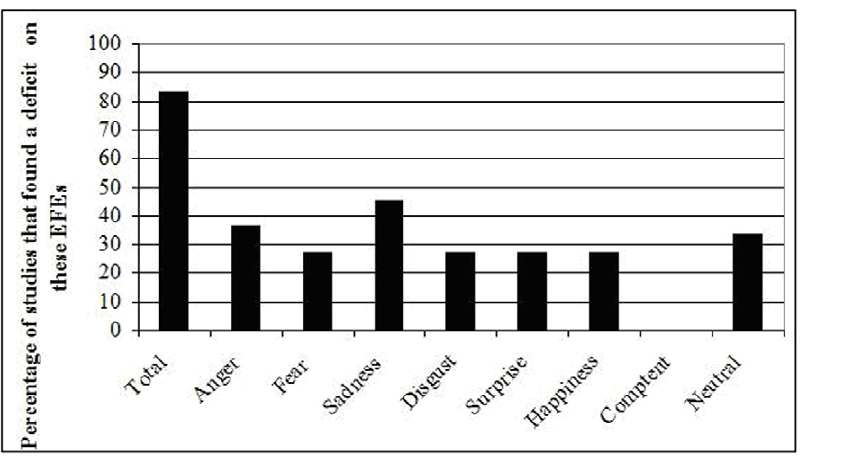
Figure 1. Behavioral deficits (in percentage) among high alexithymia scorers to process emotional and neutral facial expressions, without controlling for confounding factors. The deficits refer to the number of studies that found a deficit for the emotion relative to the number of studies that assessed this emotion. doi:10.1371/journal.pone.0042429.g001 PLOS ONE |